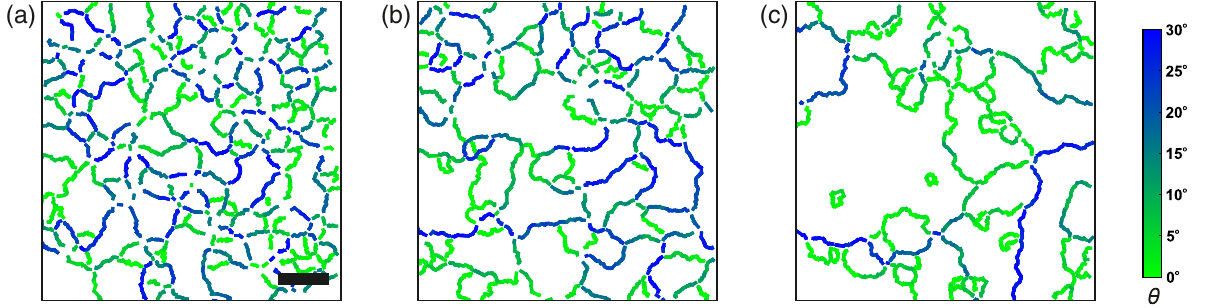
FIG. 4. (a) – (c) View of the GBs colored according to the value of their misorientation at the exact same times as in Figs. 1(a) – 1(c) and 1(d) – 1(f). This provides a direct way to visualize the SAGBs and LAGBs during coarsening. The scale bar represents 100 μ